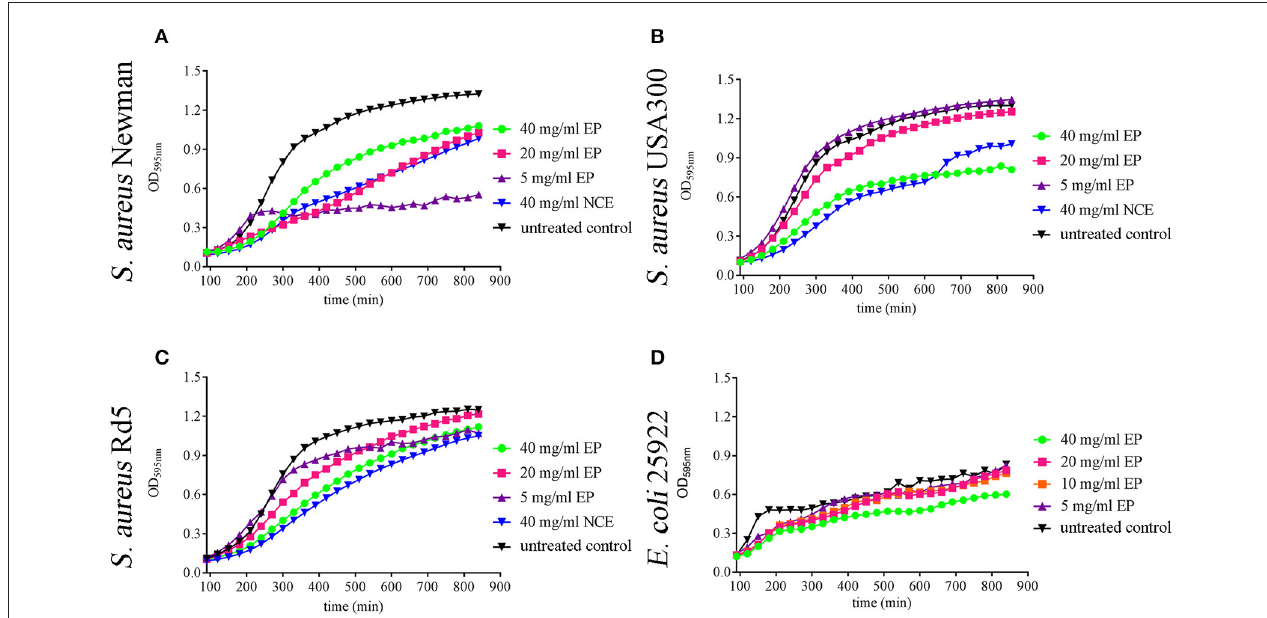
FIGURE 2 | Effect of ethanol precipitate (EP) on growth of S. aureus strains and E. coli strains in MHB over 14h. 20mg/ml and 40mg/ml EP (A) significantly inhibit the growth of S. aureus Newman at 240min and 5mg/ml inhibitory effect started at 270min ( n = 3). 40mg/ml EP (B) significantly inhibits the growth of S. aureus USA300 at 210min ( n = 3). 40mg/ml EP significantly inhibits the growth of S. aureus RD5 at 270min (C) ( n = 3). 40mg/ml EP significantly inhibits the growth of E. coli 25922 at 120min and the inhibitory effect of 20mg/ml started at 150min (D) ( n = 3). Statistical analysis was done by two-way ANOVA followed by Dunnett’s test compared to the untreated control. Each treatment was performed in duplicate and a mean value was used for statistical analysis. P ≤ 0.05 were considered